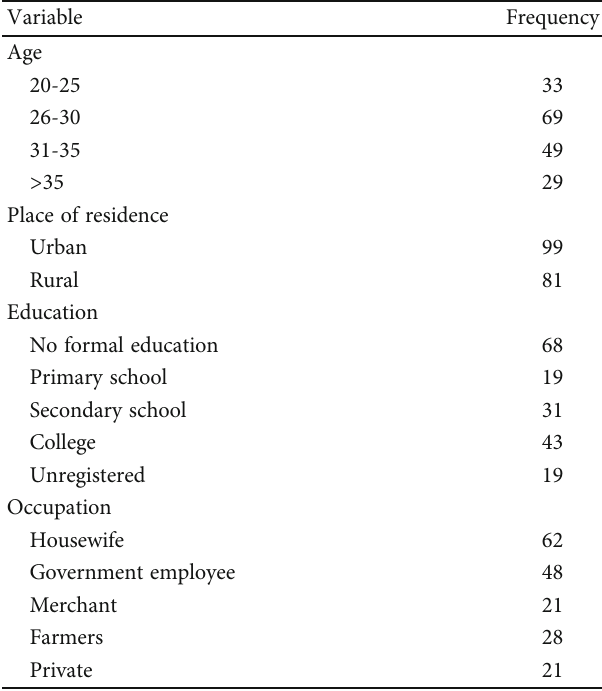
Table 2: Clinical characteristics before myomectomy of women who underwent myomectomy in SPHMMC, Addis Ababa,